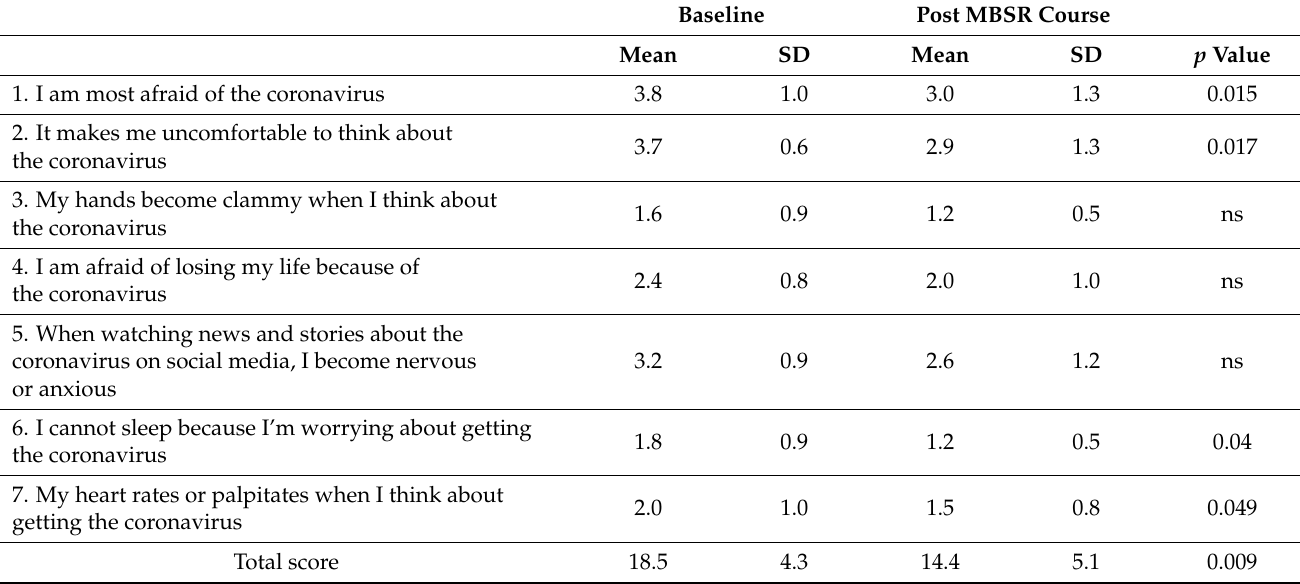
Table 4. Items and total FCS-19 in Group III before and after the MBSR